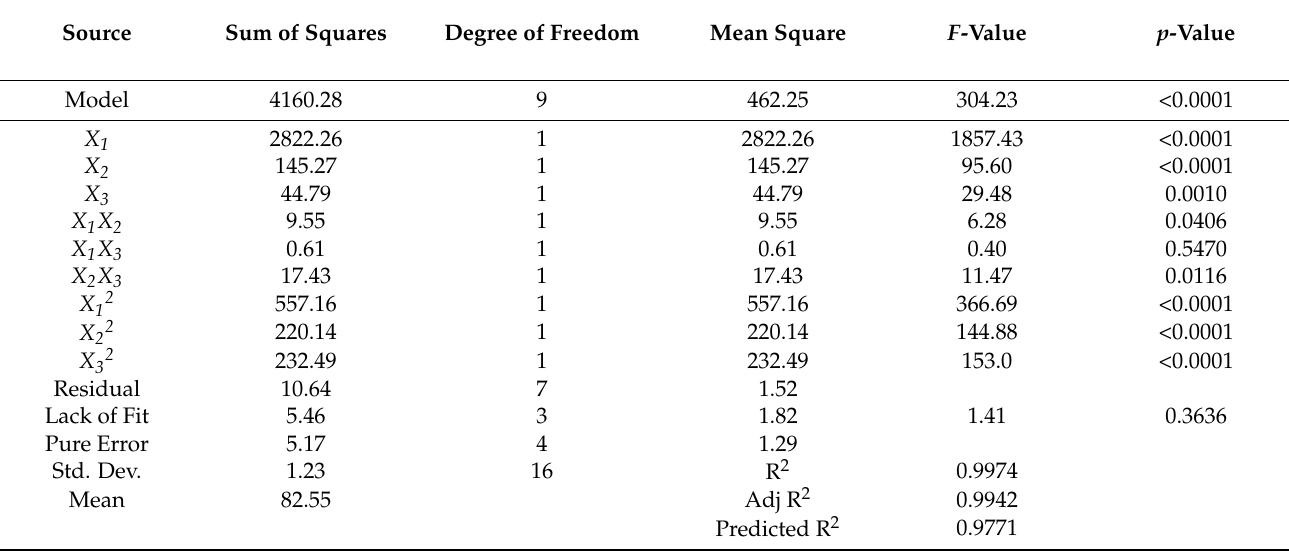
Table 2. ANOVA results for MB